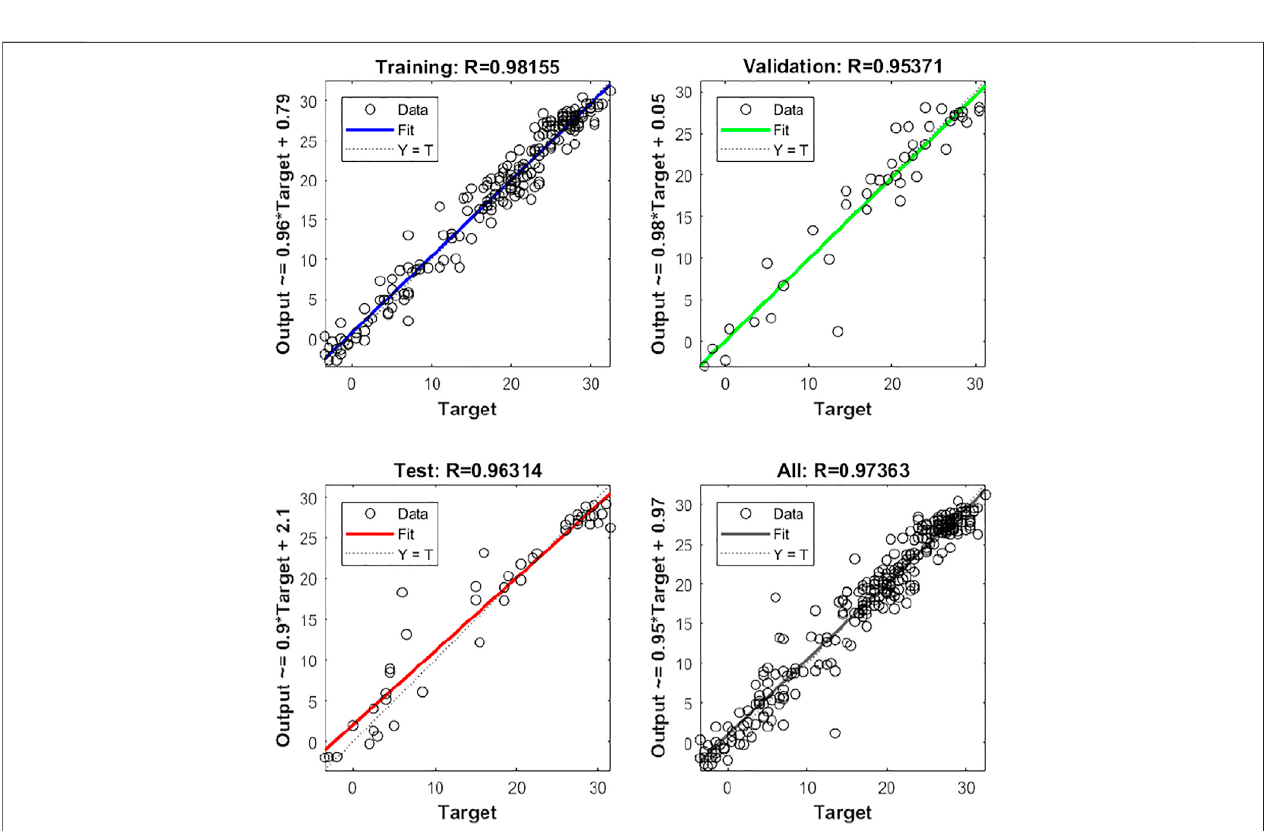
FIGURE 6 | Training